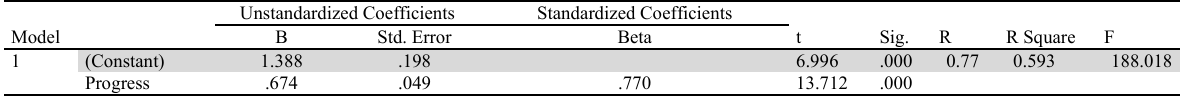
The results of testing the third sub-hypothesis Model